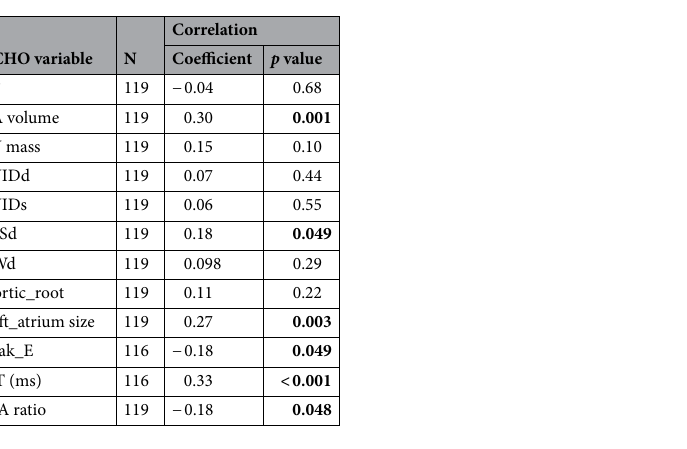
Table 4. Correlations between FKBPL and ECHO variables in non-diabetes/control group. p values <0.05 are in